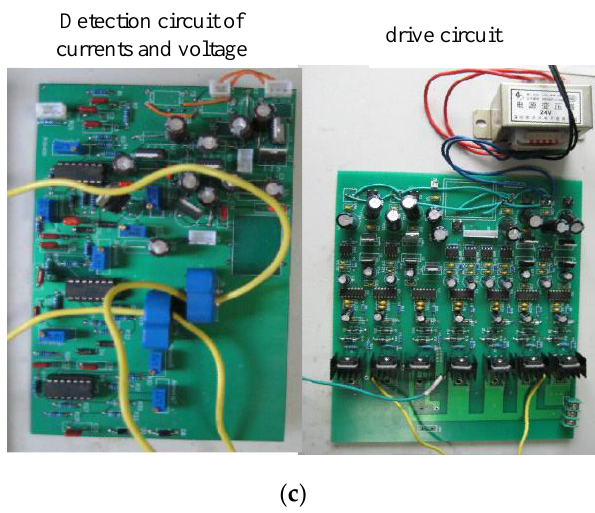
Figure 11. Experimental setup of the PMSM: ( a ) system hardware structure; ( b ) experimental PMSM; ( c ) control circuit.